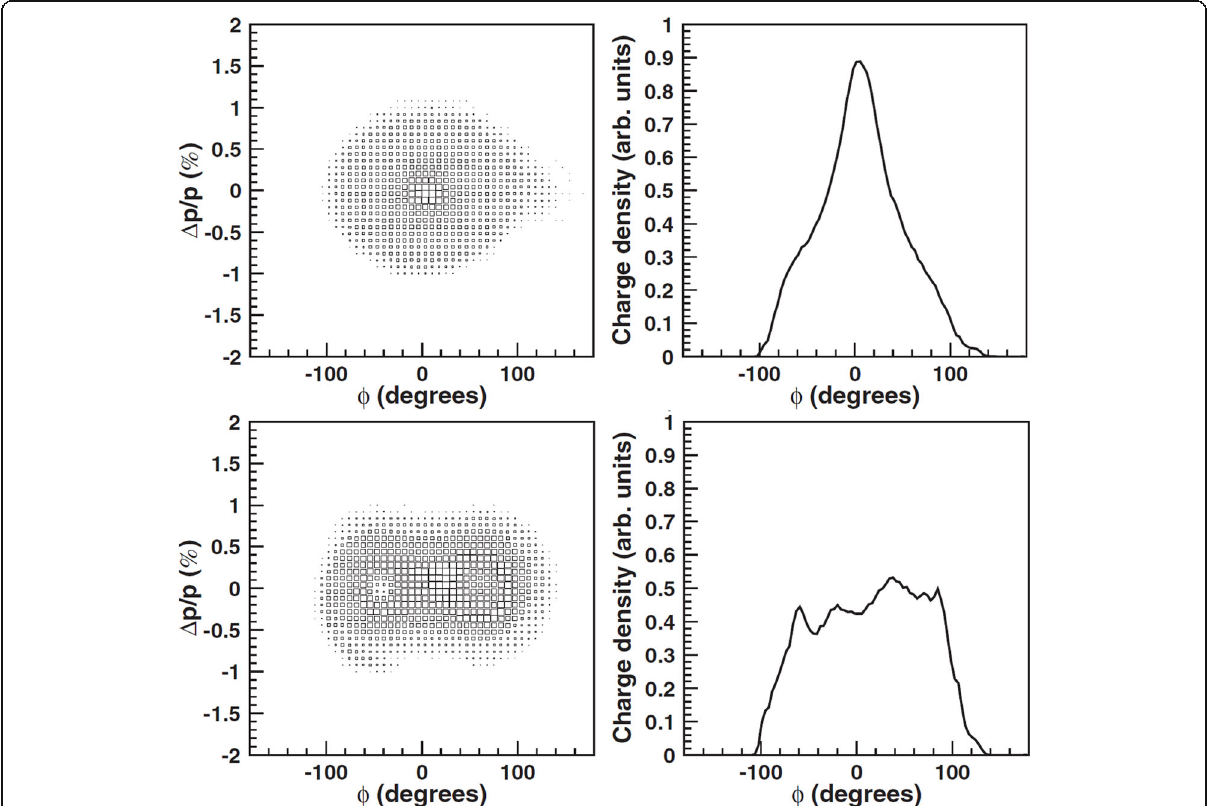
Fig. 17 Simulation results for the J-PARC RCS; particle distributions on the longitudinal phase space ( ϕ , Δ p/p) at the end of injection, obtained without (upper) and with (lower) longitudinal painting, and their projections onto the ϕ axis